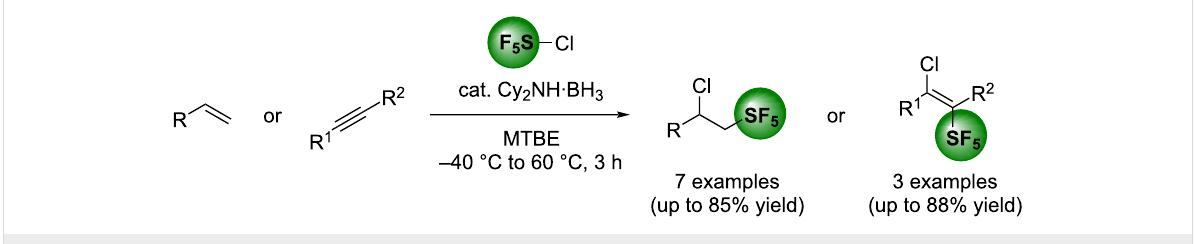
Scheme 2: Corrected graphical abstract of the original publication.